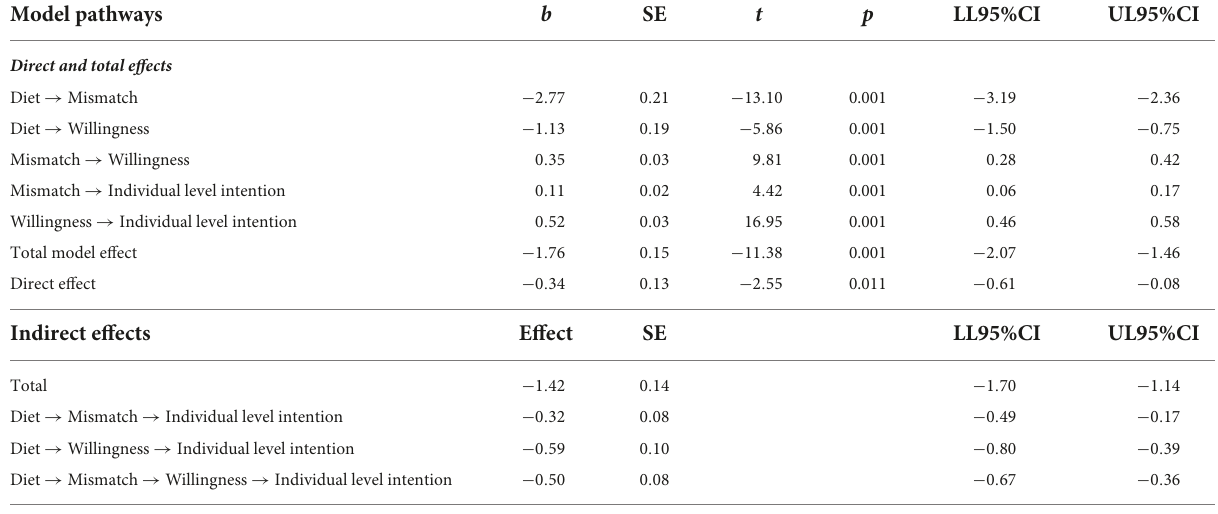
TABLE 1 Direct, indirect, and total effects of the hypothesized model A. Model pathways